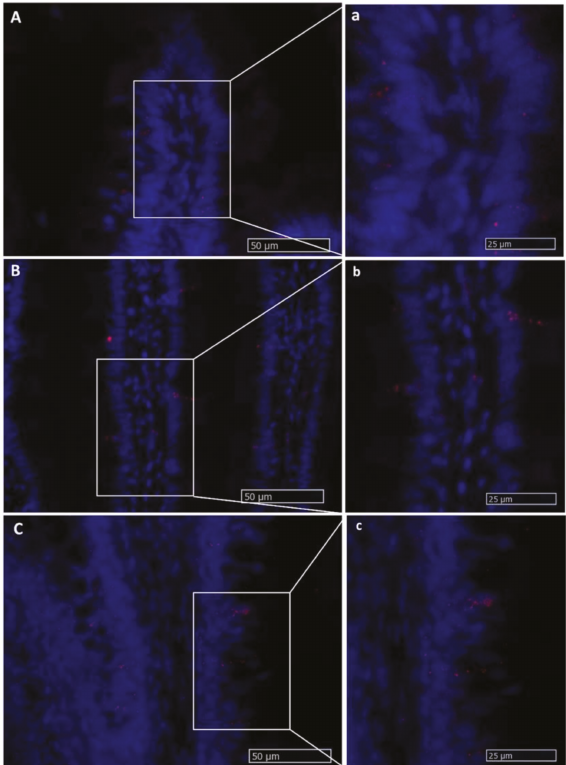
Figure 15. In situ hybridization of dll1 mRNA in di ff erent segments of the rainbow trout mid-intestine. Expression rate was lowest in the first segment of the mid-intestine ( A , a ): higher magnification) and intermediate in the pyloric caeca ( B , b ): higher magnification), whereas the signal with the highest intensity was found in the basal part of the basal part of the complex folds and in the rest of the second segment of the mid-intestine ( C , c ): higher magnification).